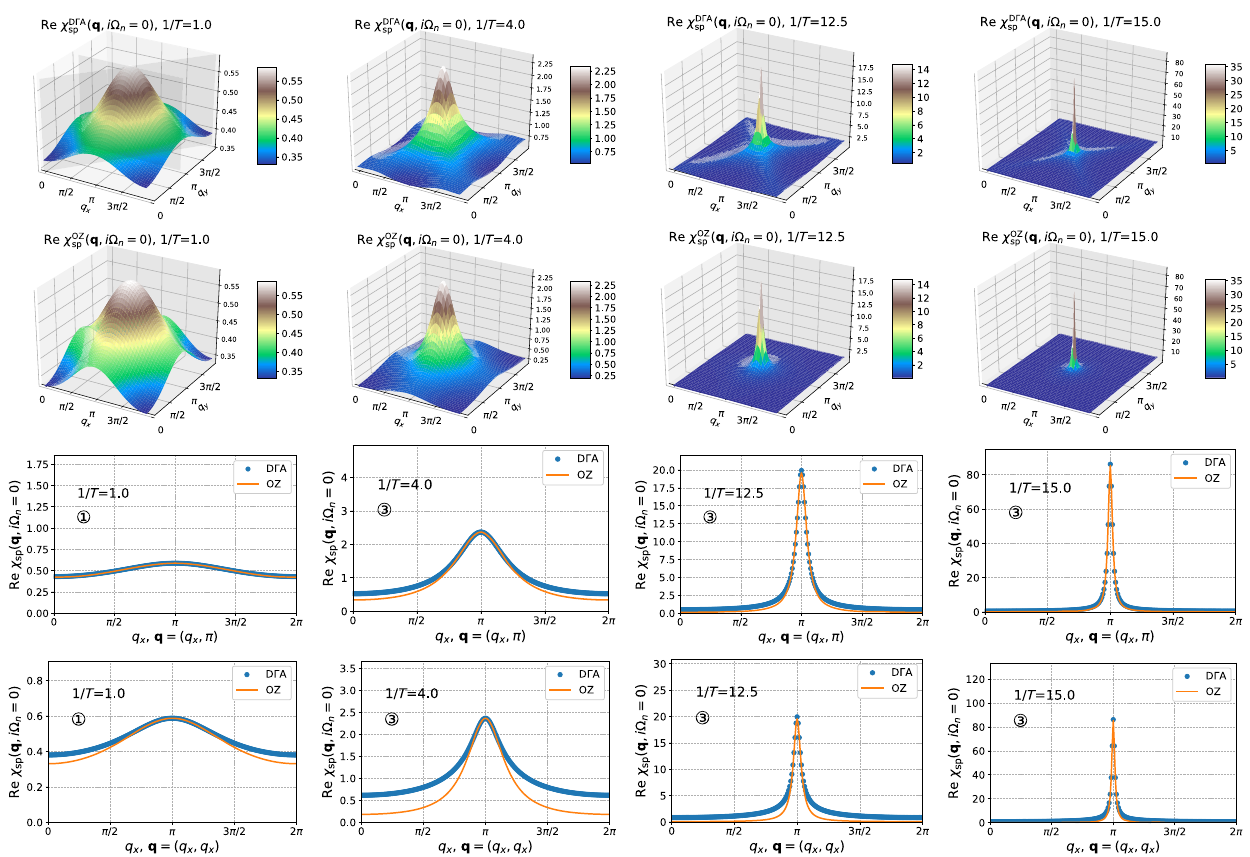
FIG. 25. Static (zero-frequency) antiferromagnetic susceptibilities obtained from D Γ A (uppermost row), the fitted data from an Ornstein-Zernike form (second row), and a comparison of both at the momentum cuts q ¼ ð q row) for various temperatures.